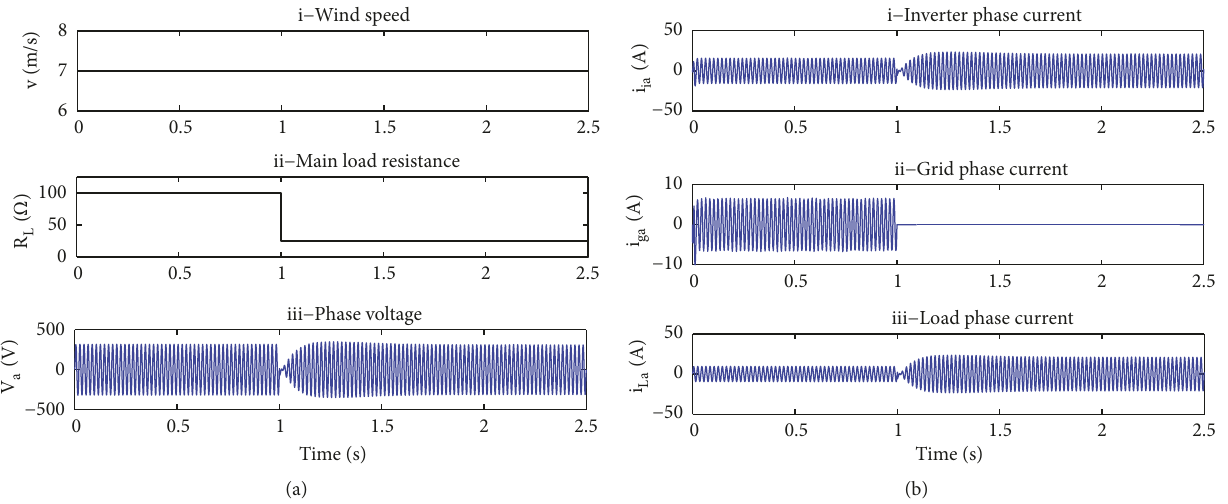
Figure 15: Performances of the grid side PI controllers in automatic switching mode. (a) Wind speed (i), main load resistance (ii), and load phase voltage (iii). (b) Inverter phase current (i), grid phase current (ii), and load phase current